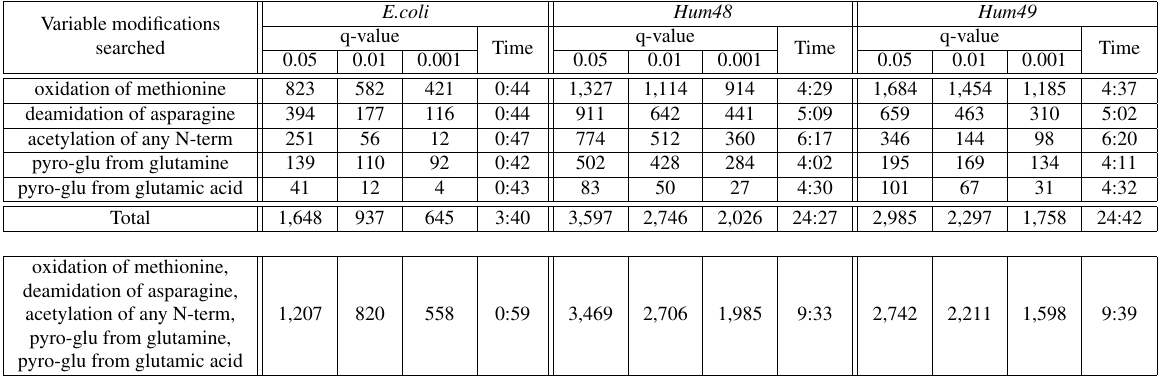
Table 5: Numbers of PSMs having variable modifications and search times [min:sec] in two cases – when variable modifications are searched separately in five search runs ( m = 1 ) and when variable modifications are searched together in a search run ( m = 5 ). Variable